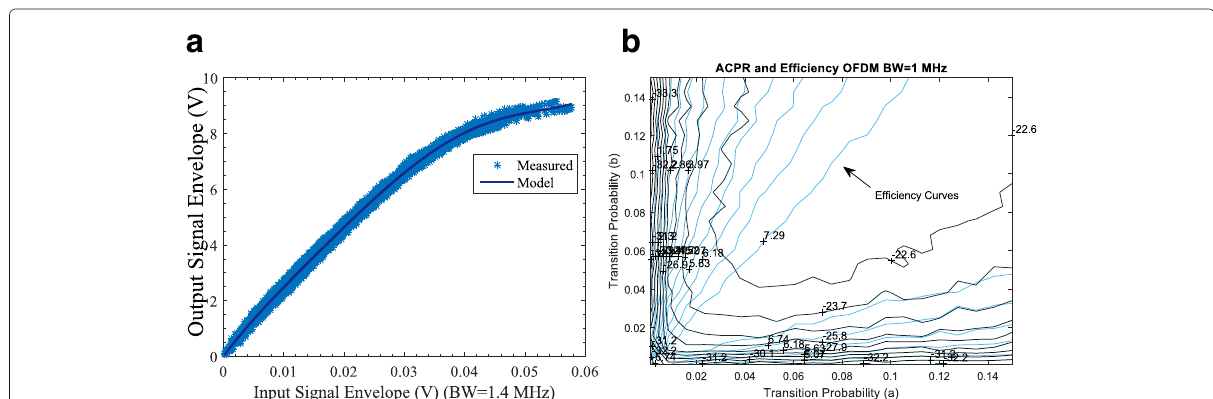
Fig. 4 Markov simulation elements. a AM-AM Cree PA-measured and PM-identified model. b 1.4 MHz Markov-LINC ACPR performance in terms of transition